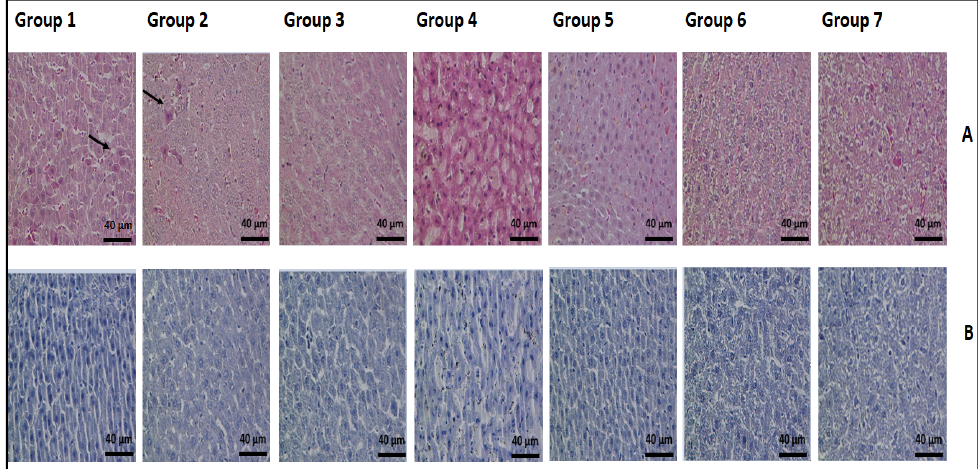
Figure 2. The histopathological examination of the liver tissue in all groups of rats (magnification × 400). ( A ) H&E-stained sections; ( B ) AB/PAS-stained sections. Arrows point to the indication area.